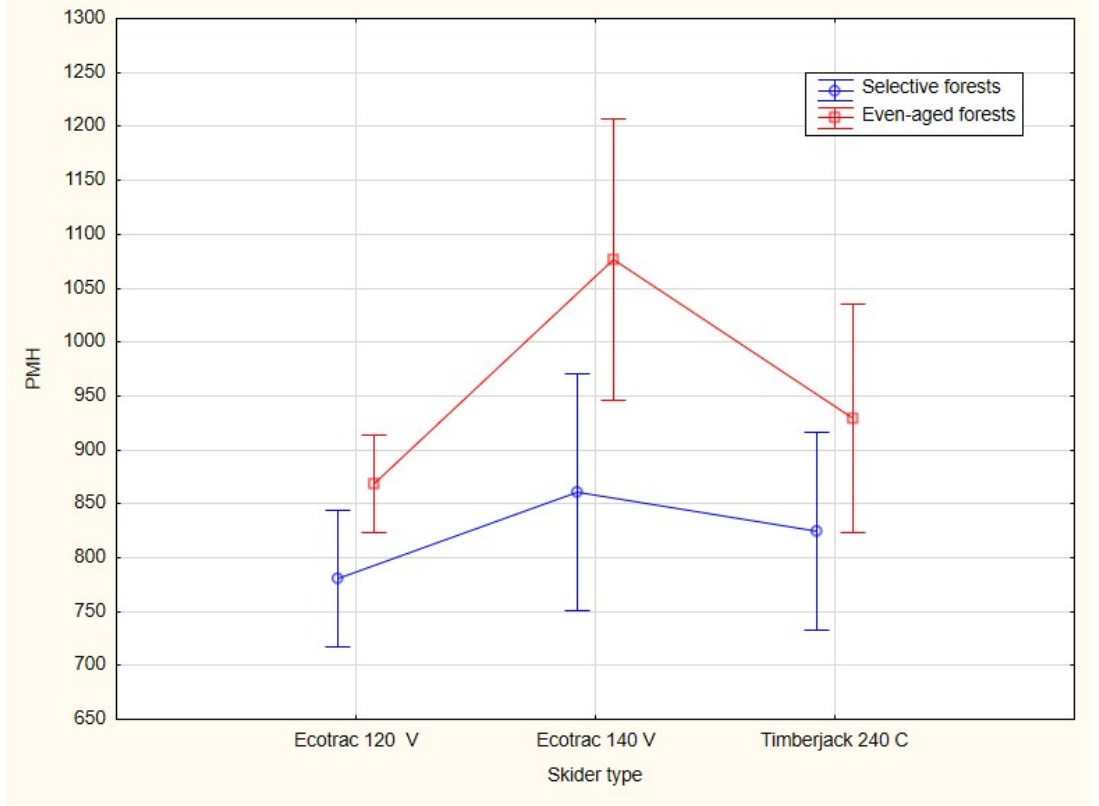
Figure 6. Total average PMH of skidders.